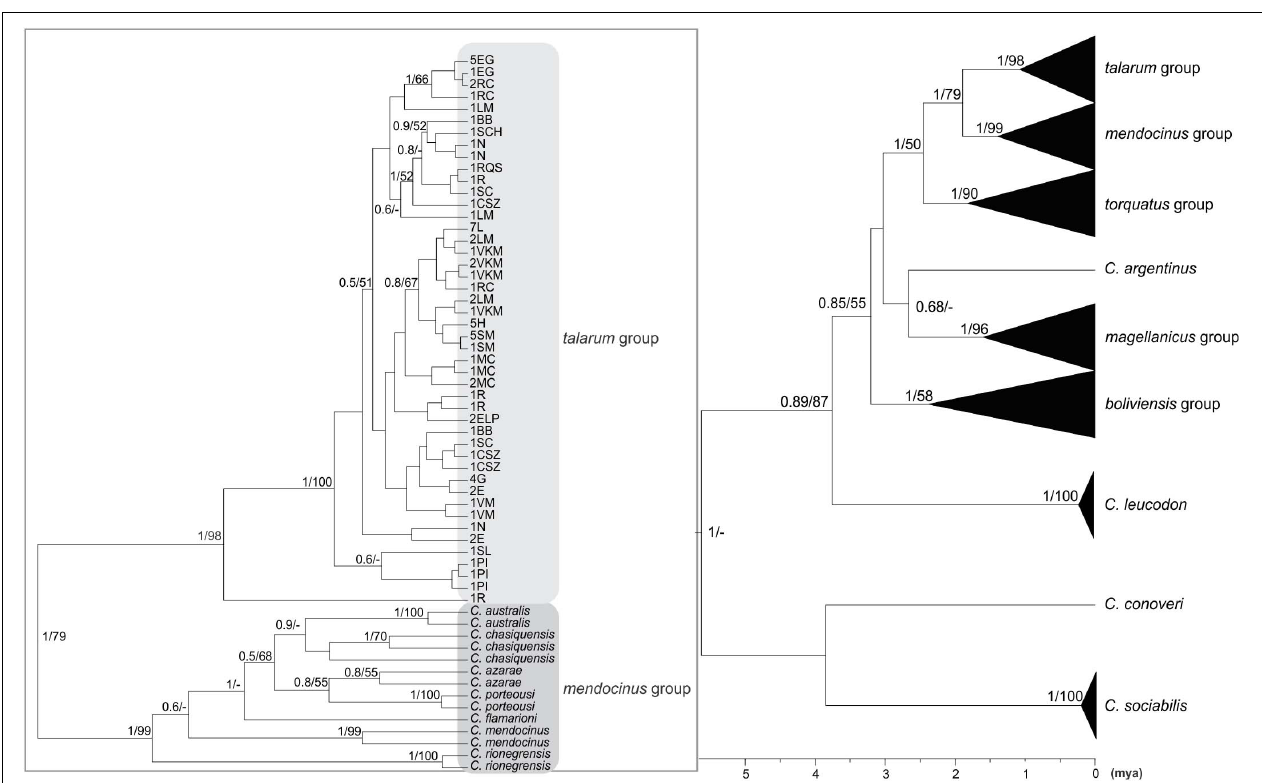
FIGURE 3 | Bayesian inference phylogenetic tree based on concatenated dataset (1,574 bp). The numbers on the nodes represent the values of node support in the Bayesian (between 0 and 1; values higher than 0.5 are shown) and Maximum Likelihood (between 0 and 100; only values higher than 50 are shown) inferences. Bar at the bottom denotes the time from the root of the tree to the present time expressed in million years ago (mya). In the left part, clades belonging to talarum and mendocinus groups are shown. The terminals represent different haplotypes, each with the abbreviations of the sampling locations to which it belongs, and its frequency, as well as the species to which it was previously assigned (if applicable). The abbreviations of sampling locations are detailed in Table 1 and the detail of sequences extracted from GenBank database is indicated in Table 3